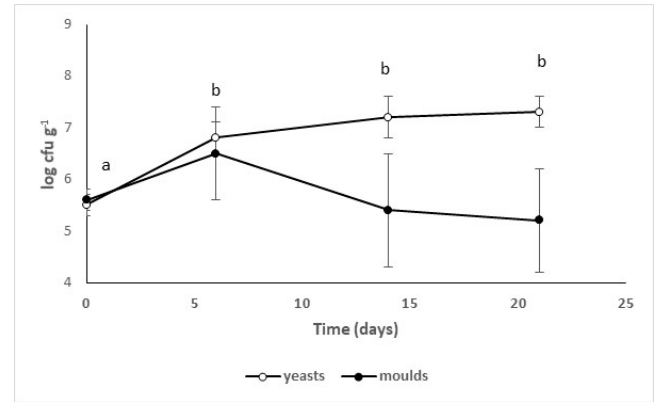
Figure 5. Yeasts and molds during the ripening of traditional sausages inoculated with Lb. casei LC01. Mean value ± standard deviation. The letters and the symbols indicate significant differences for each microbial group (one-way ANOVA and Tukey’s test, p < 0.05).